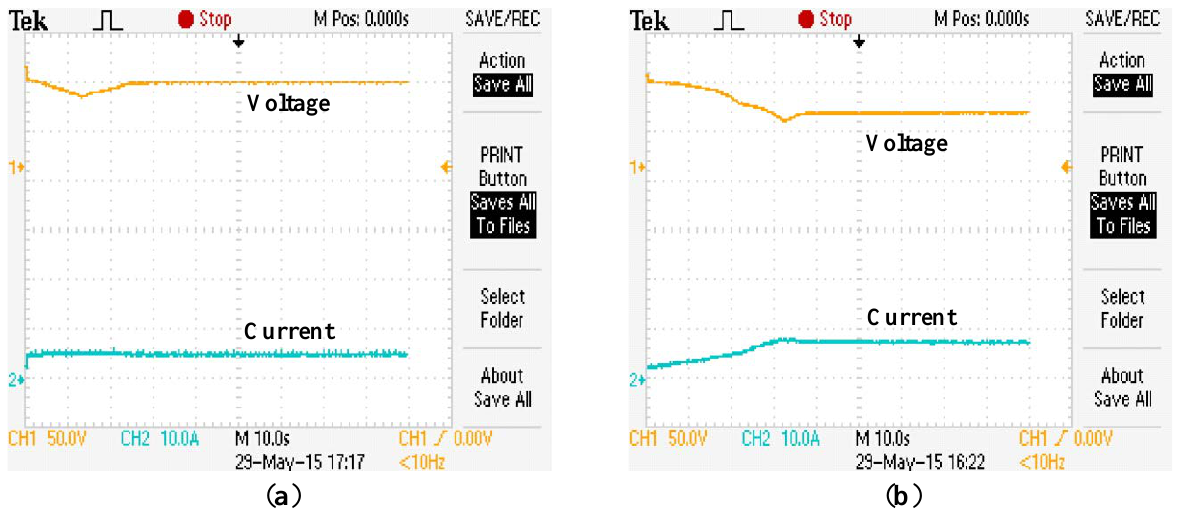
Figure 24. PV output power for the scenario of Figure 22b.